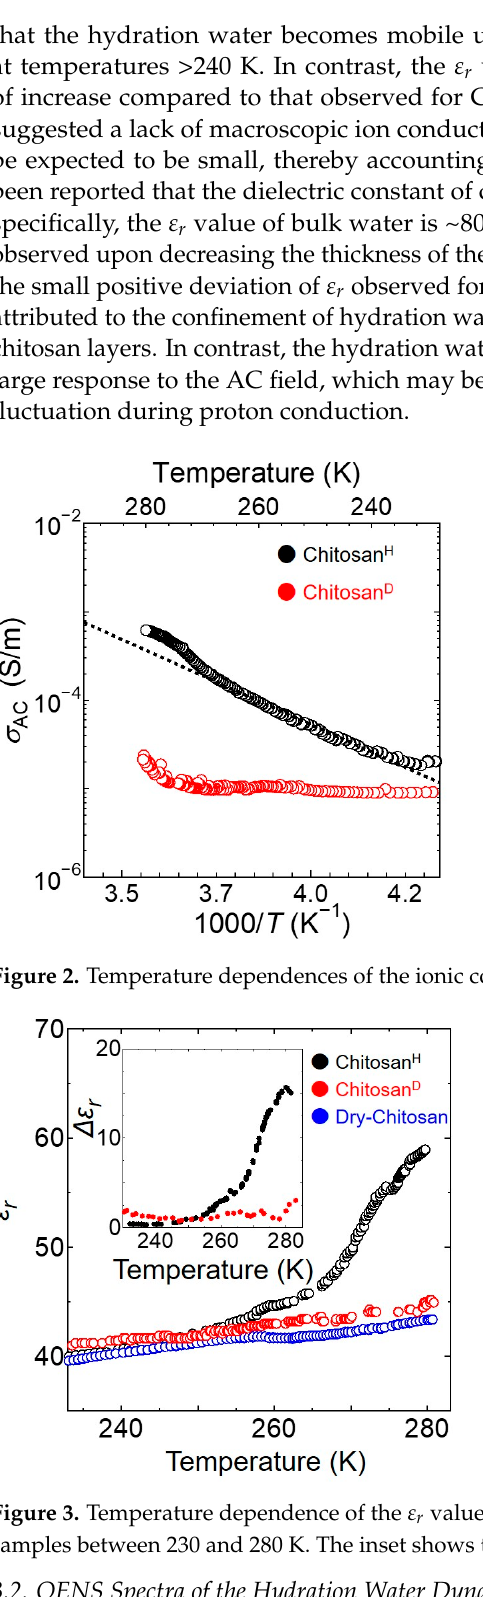
Figure 4. QENS profiles of S H − D ( Q , ω ) at Q = 1.0 Å − 1 in the energy range of − 500 to 1500 µeV with a resolution of 12 µeV at 238 K (purple), 253 K (blue), 268 K (green), and 283 K (red). S H − D ( Q , ω ) is the scattering intensity that represents the water dynamics of the hydrated chitosan, and is obtained by